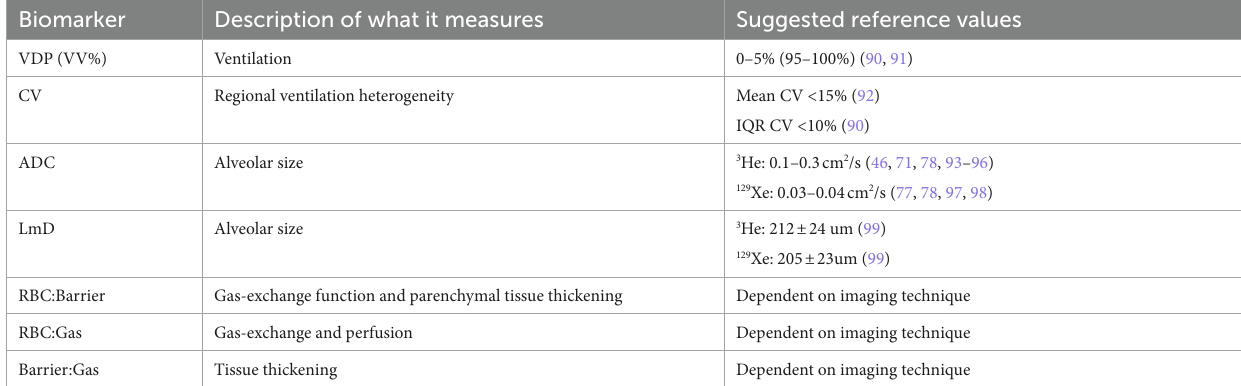
Dependent on imaging